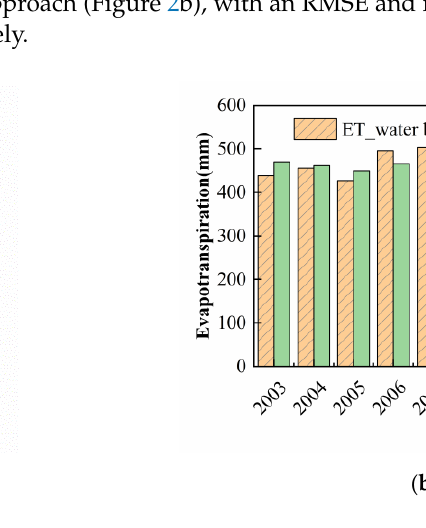
Figure 2. Comparisons of ET estimated from HTEM with observed ET at field scale ( a ) and regional ET estimated from water balance analysis ( b ).